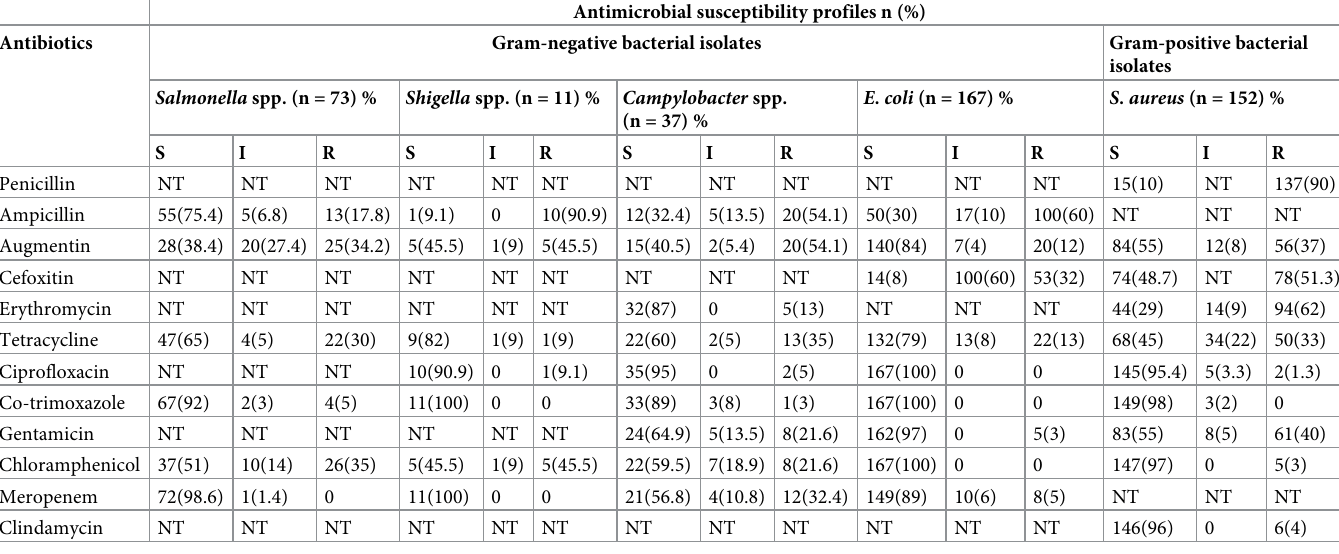
Table 4. The antimicrobial susceptibility profiles of bacterial isolates from RTE raw minced meats served in hotels and restaurants of Arba Minch town from 01 July to 31 December, 2020. Antimicrobial susceptibility profiles n (%) Antibiotics Gram-negative bacterial isolates Gram-positive bacterial